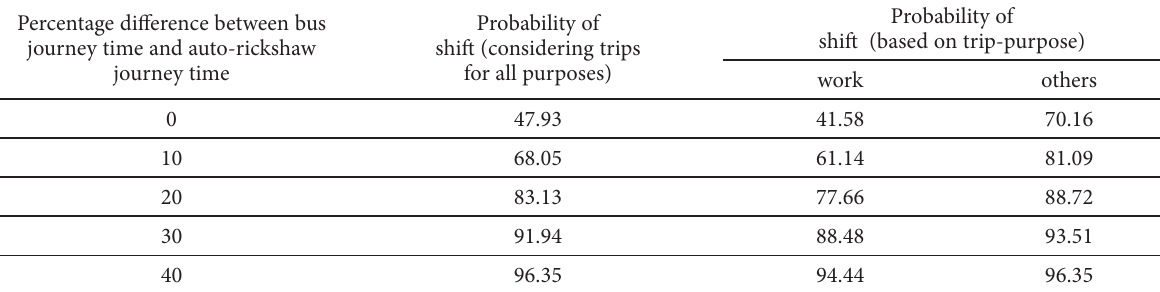
Table 5. Th e probability of the shift of auto-rickshaw users to the bus Percentage diff erence between bus journey time and auto-rickshaw journey